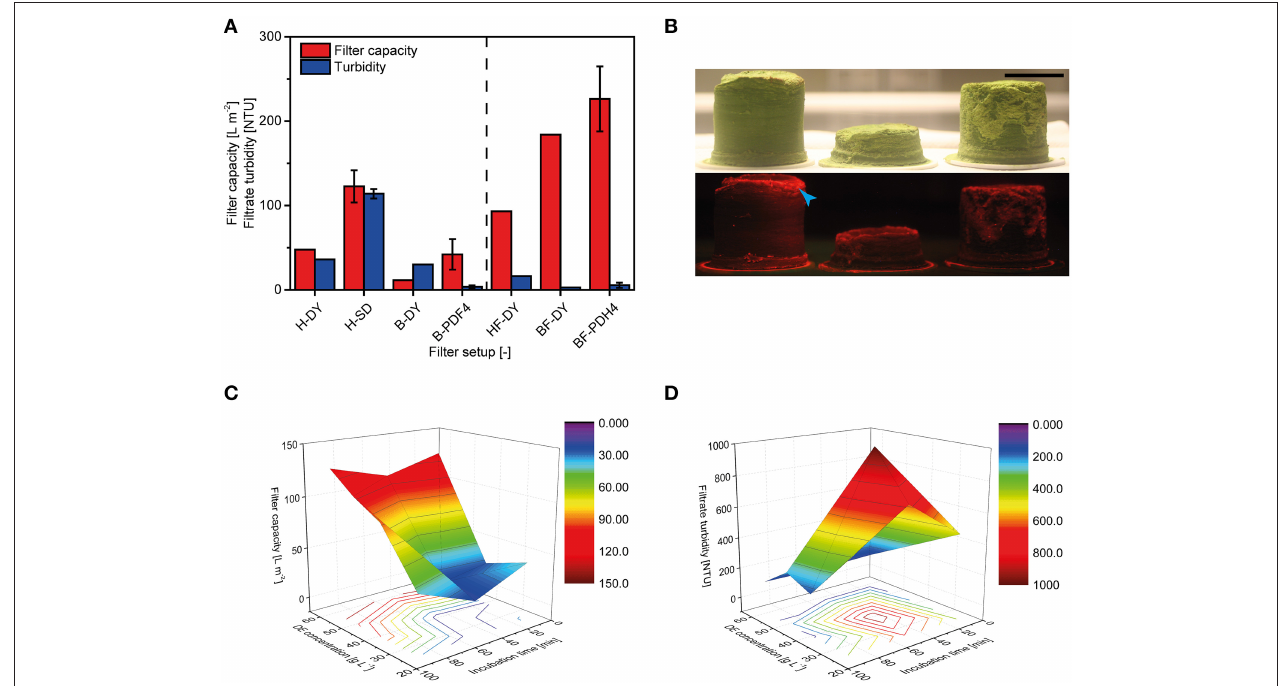
FIGURE 5 | Clarification of plant extracts using pre-coat filters. (A) Filter capacity and filtrate turbidity achieved using bottle-top (DY) and small-scale filter devices (SD) fed with bulk plant homogenate (H) or bag filtrate (B). Results shown to the right of the dashed line originate from experiments in which 2.0g L − 1 Polymin P was added to the homogenate prior to further processing. Error bars indicate standard deviations ( n ≥ 3 ). (B) Photographs of filter cakes under ambient light (top) or green light with red filter (bottom) obtained from SD filters using 50 (left), 25 (middle), or 40 (right) g L − 1 DE. Red fluorescence originating from the target protein DsRed is highlighted with a blue arrowhead. Size bar = 30mm. (C) The dependence of SD filter capacities on DE concentration and incubation time, from DoE runs. (D) The dependence of SD filtrate turbidities on DE concentration and incubation time, from DoE runs. The number of DE additions did not affect filter capacity or filtrate turbidity in the experiments shown in (C,D)